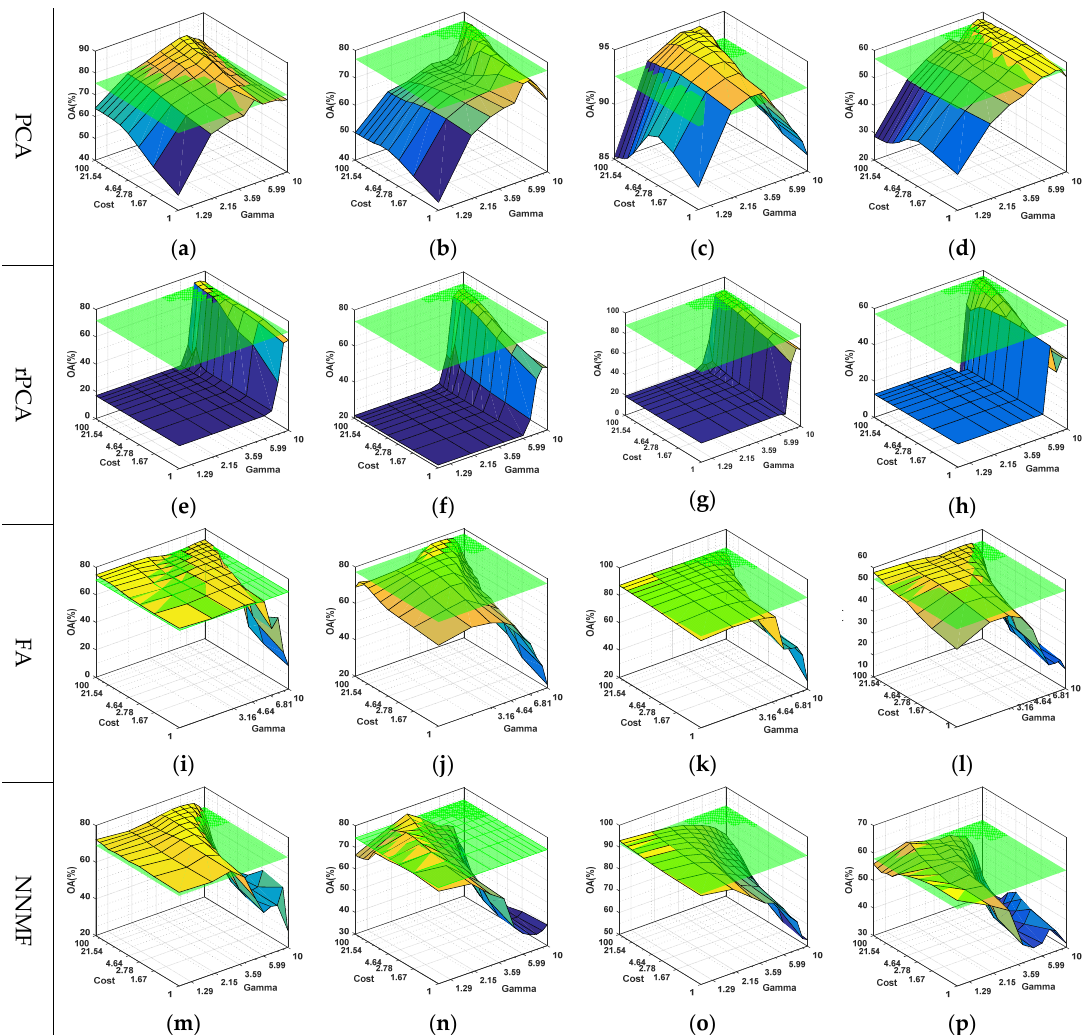
Figure 5. Overall Accuracy (OA) versus GFKSVM with RBF and linear kernel (green transparent flat surface) for ROSIS data (PCA-PCA: ( a ) University → University; ( b ) University → Center; ( c ) Center